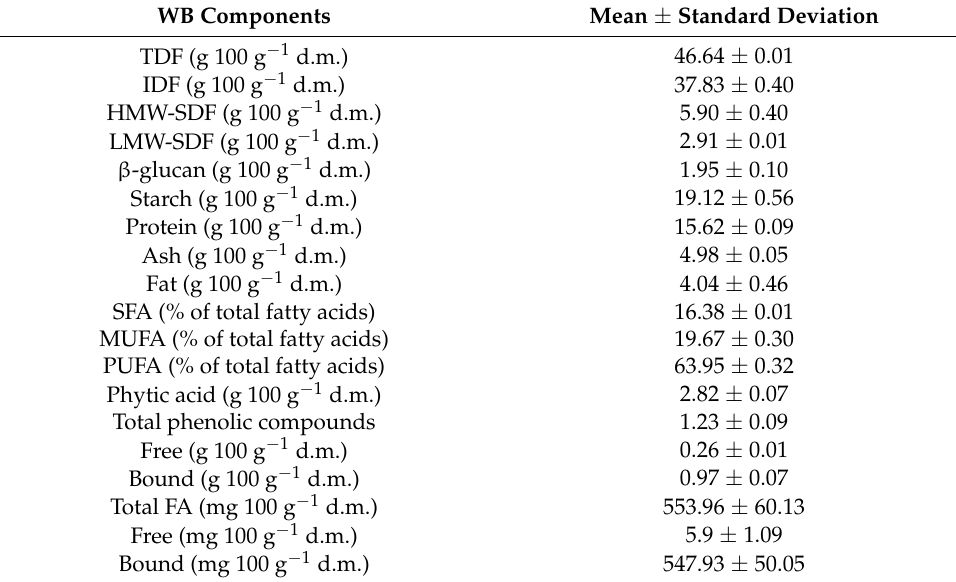
Table 1. Chemical composition of wheat ( Triticum aestivum L. var. Craklin) bran. WB